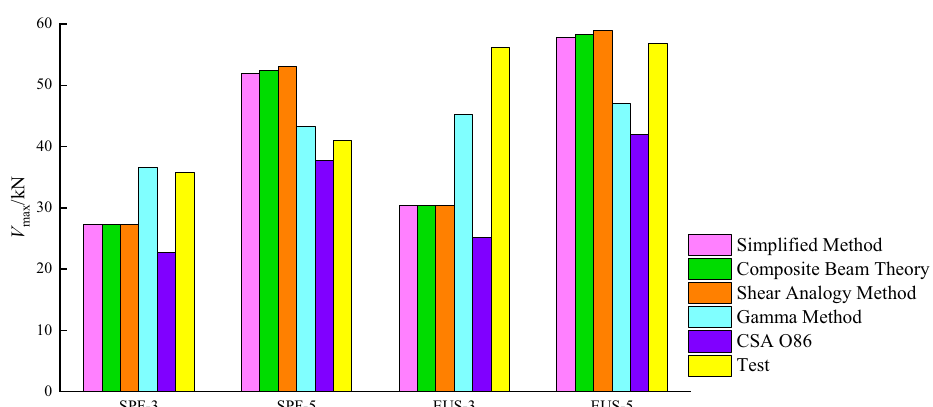
Fig. 8 Comparison of the mean values of shear capacities of the test specimens obtained by different analytical models